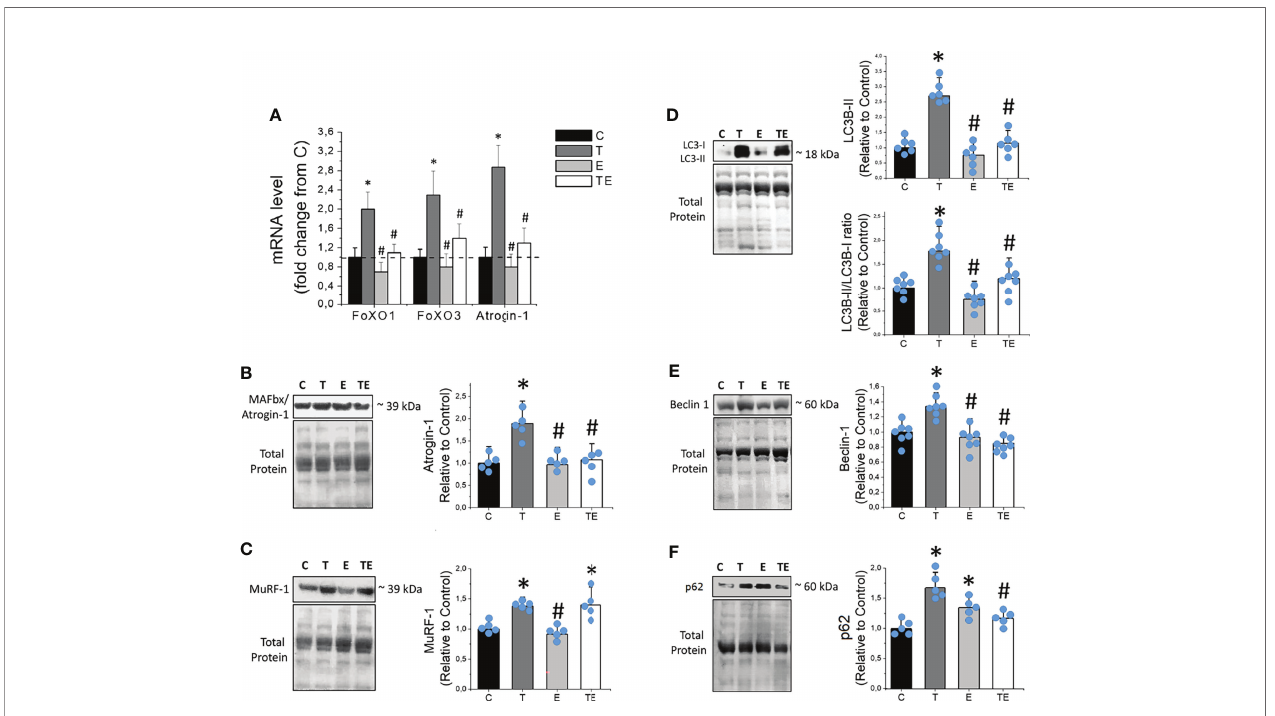
FIGURE 5 | Resistance exercise prevents tumor-induced elevation of proteolytic key genes and proteins linked to ubiquitin-proteasome and autophagy system. (A) Skeletal muscle mRNA levels of FoXO1, FoXO3 and Atrogin-1 (n = 6). (B) Skeletal muscle protein levels of MAFbx/Atrogin-1(n = 5), (C) MuRF-1 (n = 5), (D) LC3B-II and LC3B-II/LC3B-I ratio (n = 6), (E) Beclin-1 (n = 6) and (F) p62, of control, tumor-bearing, exercised and tumor-bearing exercised groups. Results are mean ± standard deviation. * p < .05 , compared with control; # p < .05 , compared with Tumor-bearing group (by ANOVA two-way followed by Tukey post-hoc test). C, control group; E, exercised; FoXO, Forkhead box protein; LC3B-II, Light Chain 3B phosphatidylethanolamine conjugate; MAFbx, Muscle atrophy F-box; mRNA, messenger ribonucleuc acid; Murf-1, Muscle-speci fi c RING fi nger protein 1; T, tumor-bearing; TE, tumor-bearing